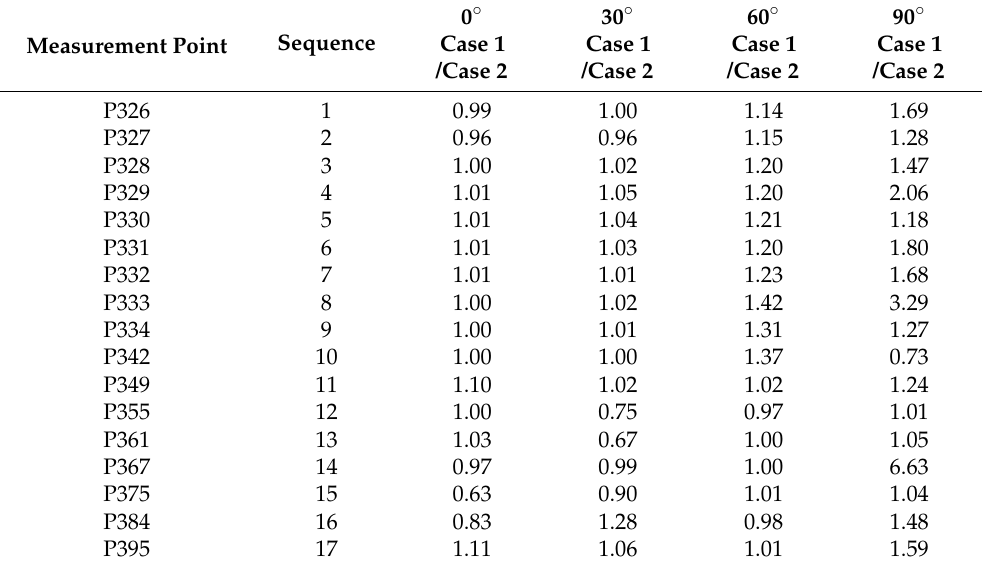
Table 3. Ratio of minimum values of wind pressure coefficients at measurement points under different